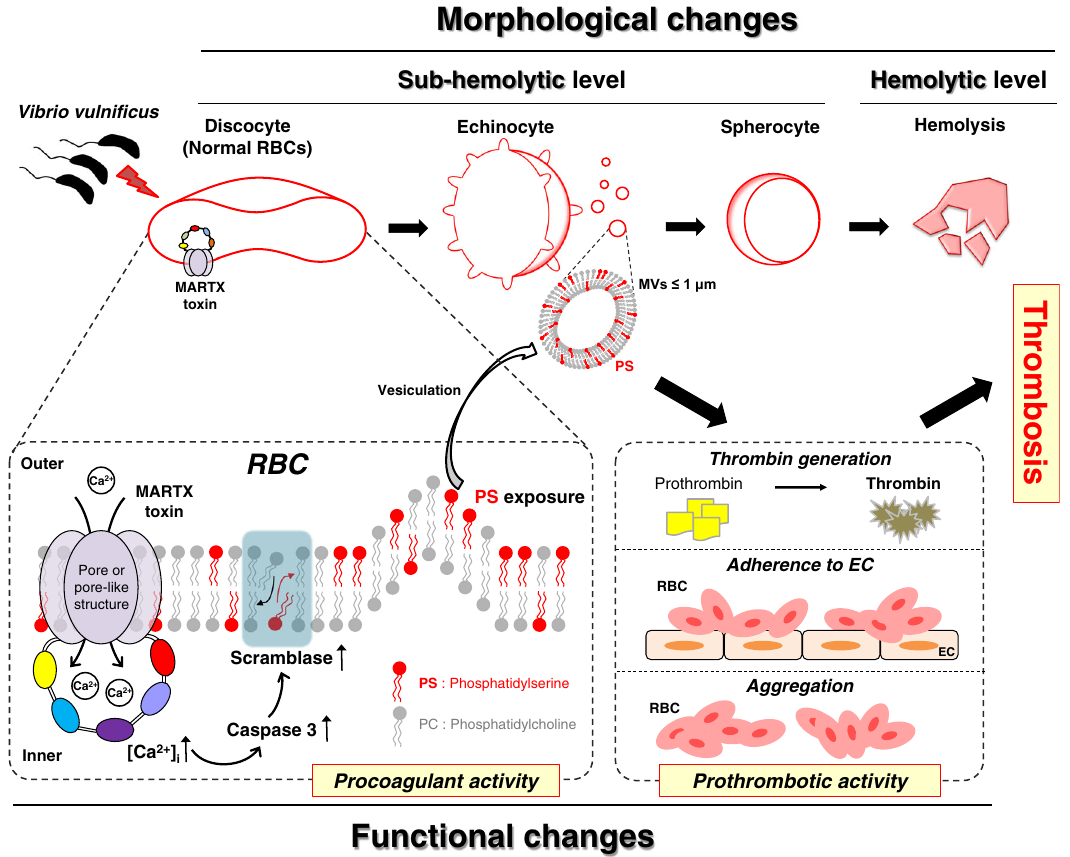
Fig. 5| Summary:effectsofthe V.vulni fi cus MARTX toxinonthe procoagulant andprothromboticactivityofhumanRBCsleadingtothrombosis. V.vulni fi cus infects RBCs at the sub-hemolytic level and produces the pore-forming MARTX toxinthatinducesprocoagulantactivityaccompaniedbytheelevationofthe[Ca 2+ ] i level, caspase-3, and scramblase activity, then leading to PS exposure and MV